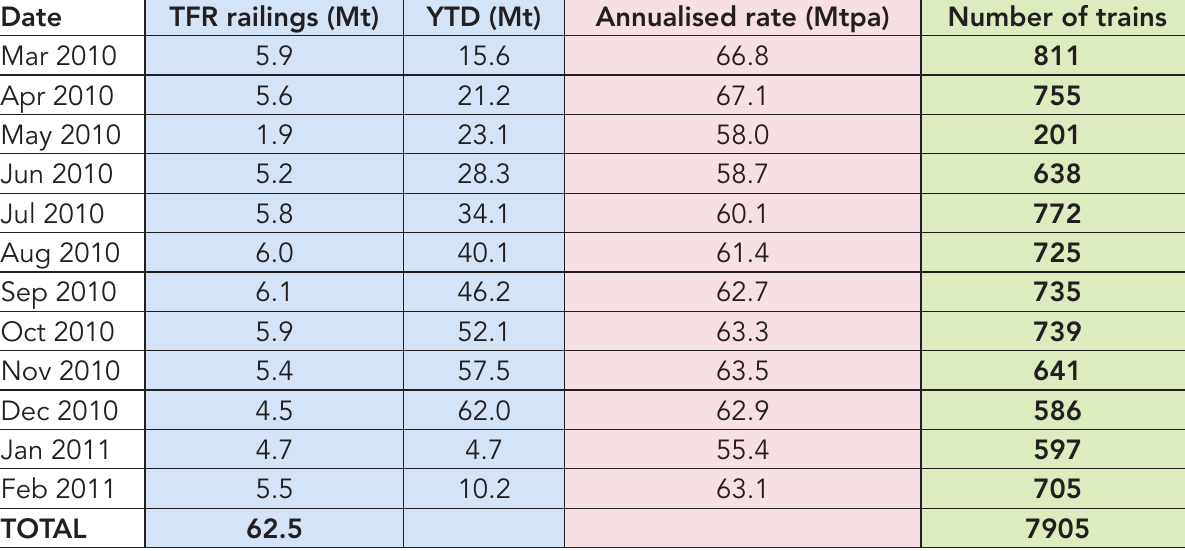
Table 3: Transnet Freight Rail’s (TFR) Operating Statistics, 2010/2011 Source: South African Coal Report